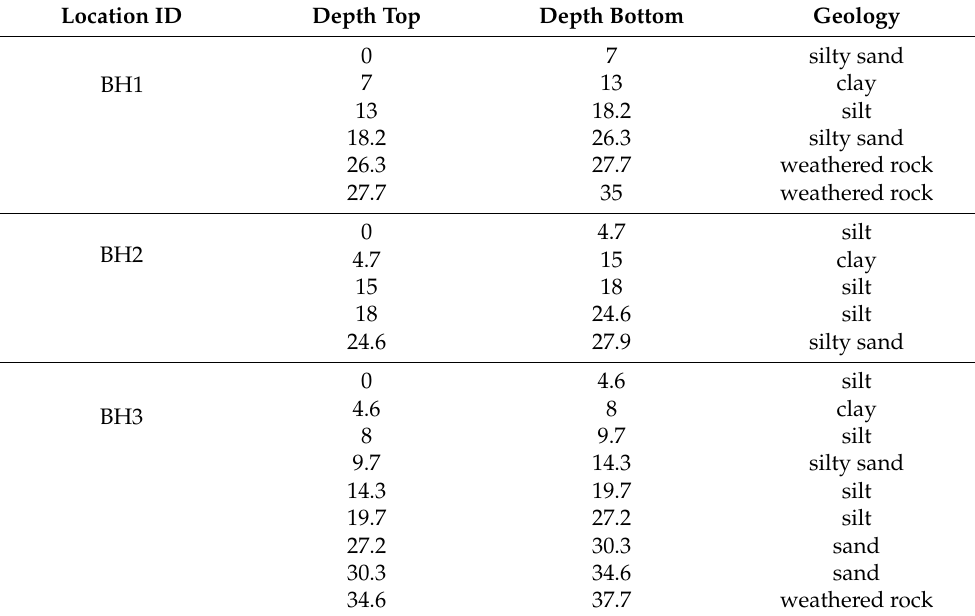
Table 3. Detailed information of some boreholes layer along with the